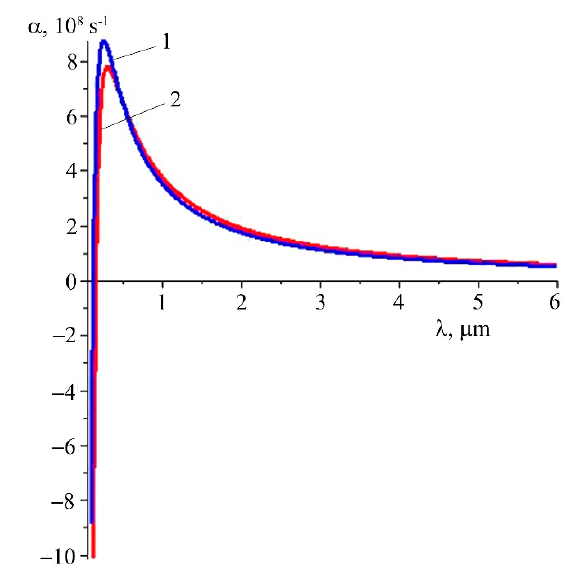
Figure 5. A growth rate characteristic of perturbations on the plasma–melt interface for a thermoelectric constant of 10 − 1 V / K: ( 1 ) Ti-Y system; ( 2 ) Al-Si-Y system.